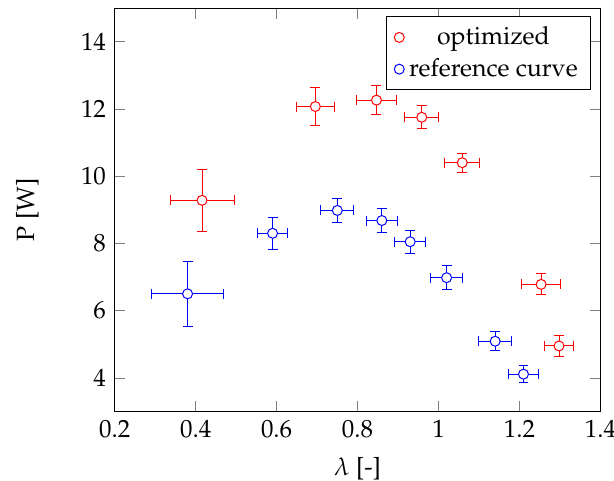
Figure 24. Characteristic curve determined experimentally in the channel at the optimum phase angle of 10 ◦